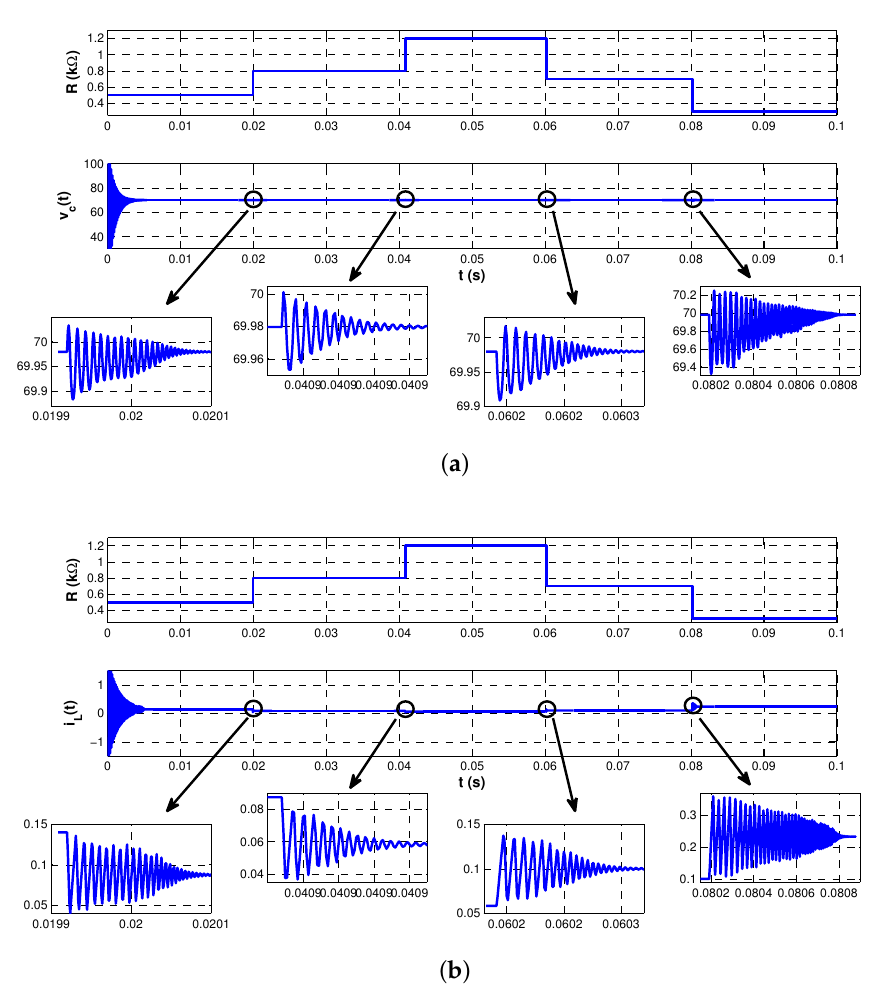
Figure 9. ( a ) Output voltage subject to load variations. ( b ) Inductor current subject to load